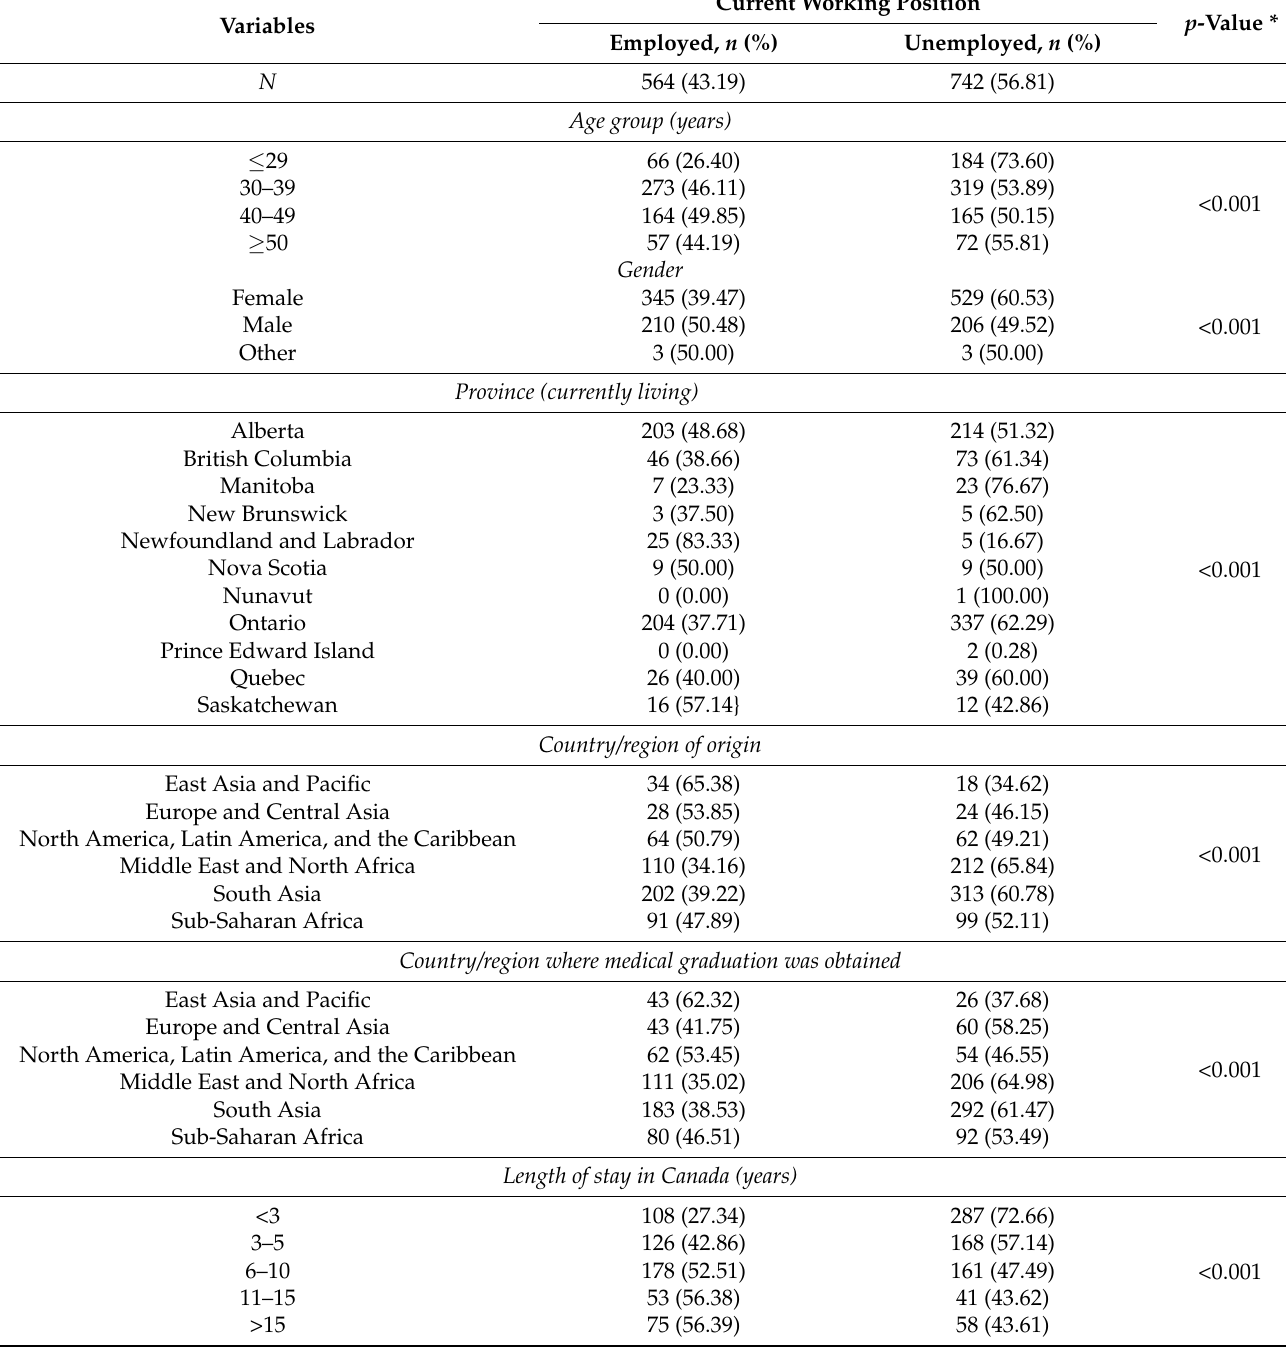
Table 1. Characteristics of the survey respondent